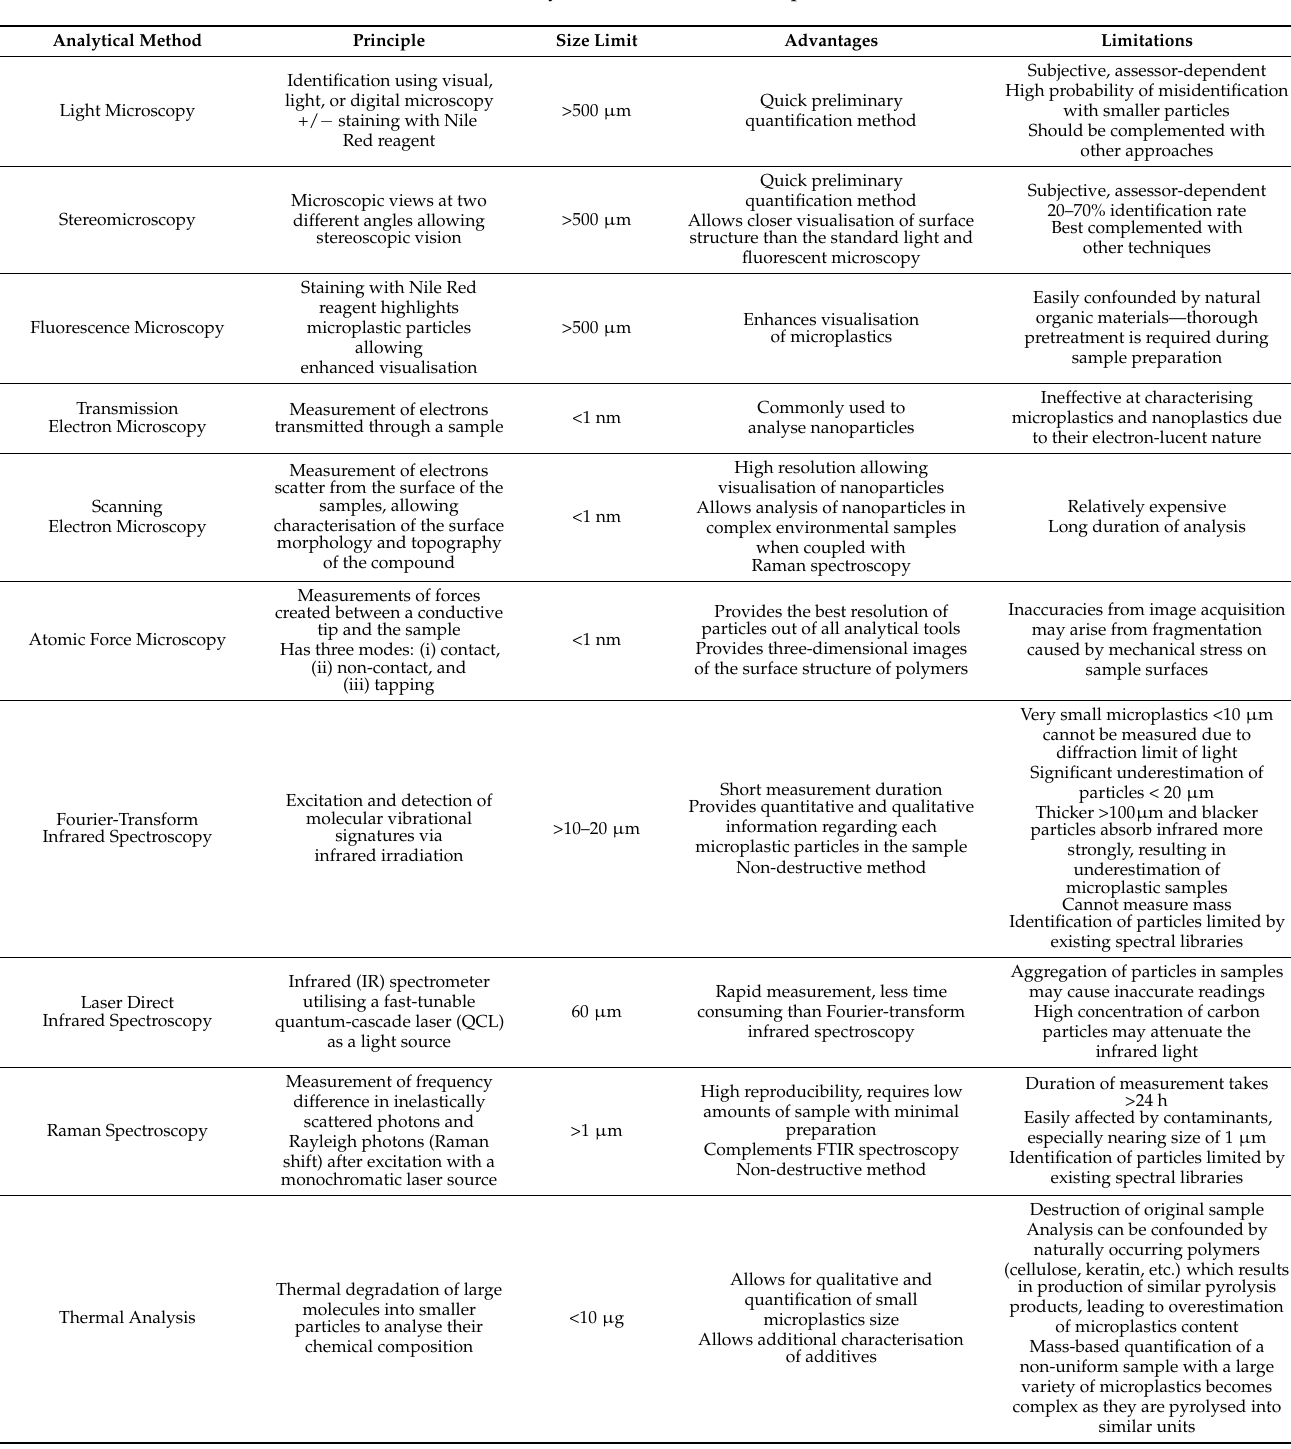
Table 1. Common analytical methods for